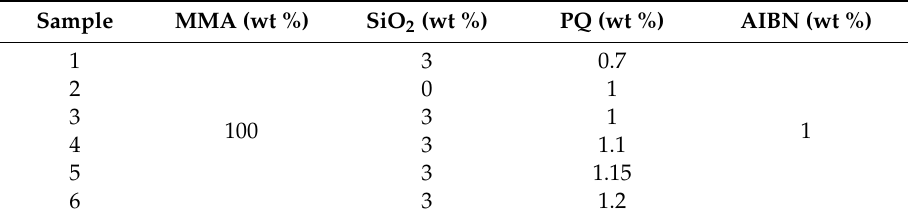
Table 1. Concentration ratio of each component in the prepared